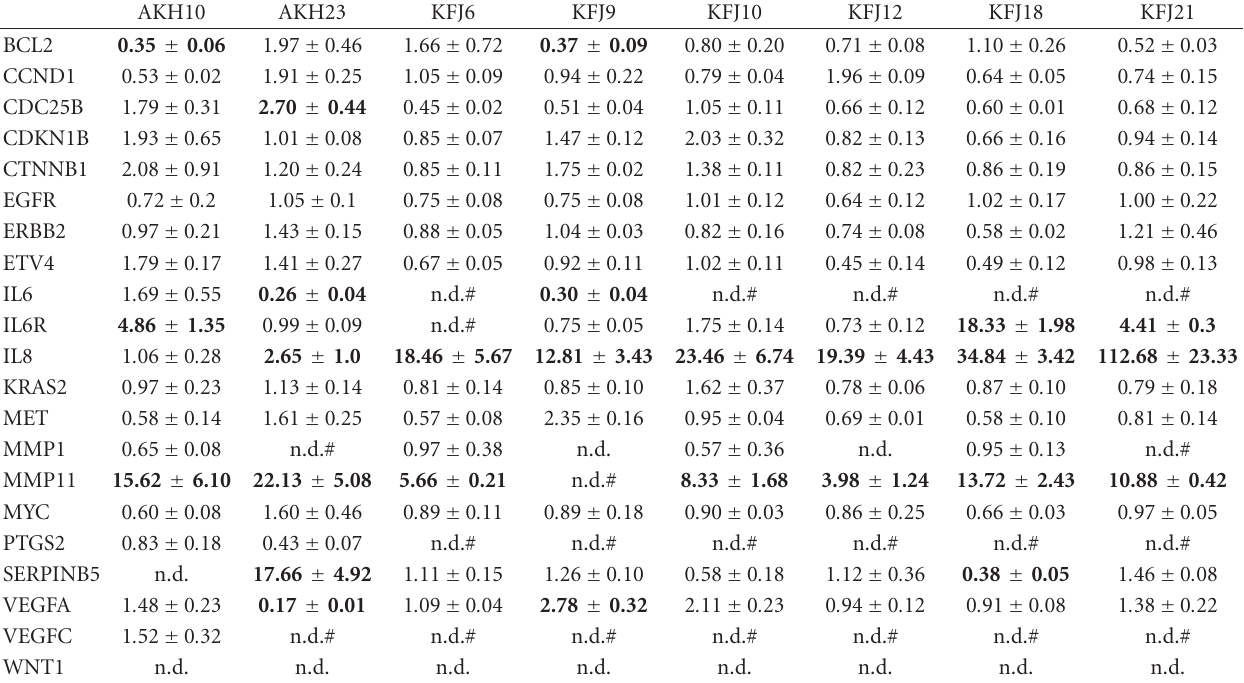
Table 4: Relative di ff erences in gene expression levels (n-fold) of original tumour samples compared to the corresponding xenograft tumour. Indicated values represent the mean of three measurements including the calculated standard deviation. Ratios were calculated after normalisation of individual RNA amounts to a standard reference RNA. Values indicating di ff erences higher than 2.5-fold are printed in bold. Gene symbols correspond with Table 1. n.d.: not determinable, Ct values obtained with cDNA derived either from the xenograft (#) or from both tumour samples were below threshold ( >